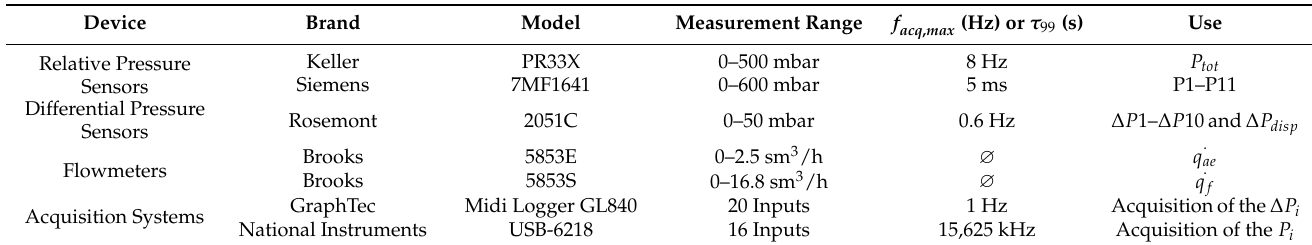
Table A1. Instrumentation of the experimental